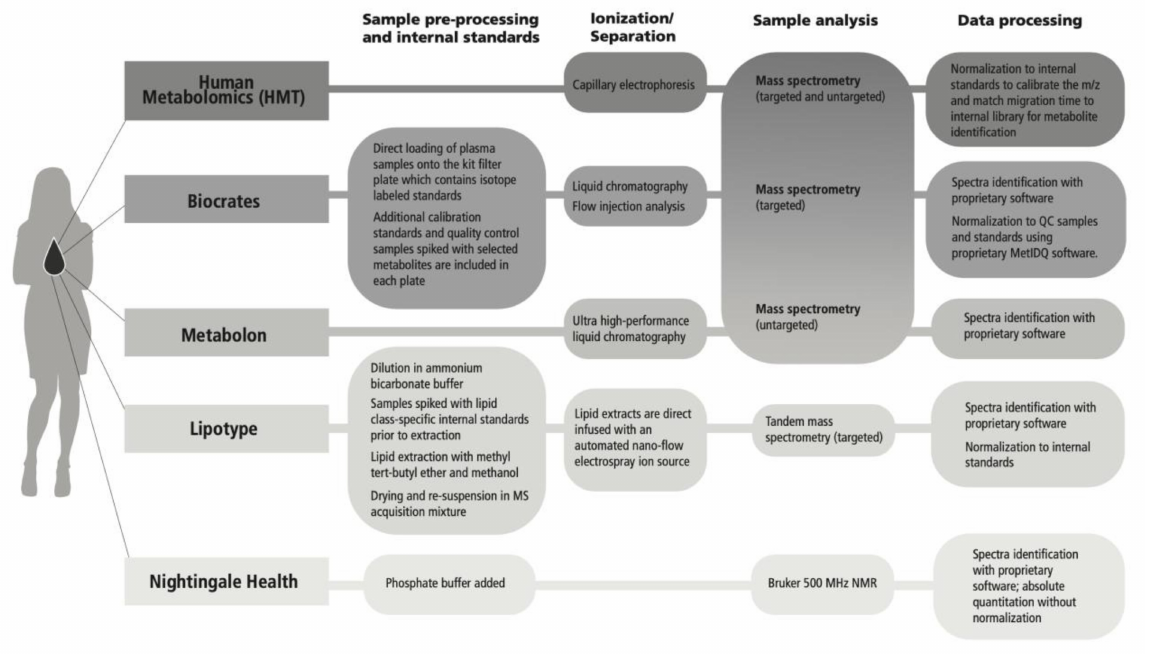
Figure 5. Metabolomics analytical methods across evaluated